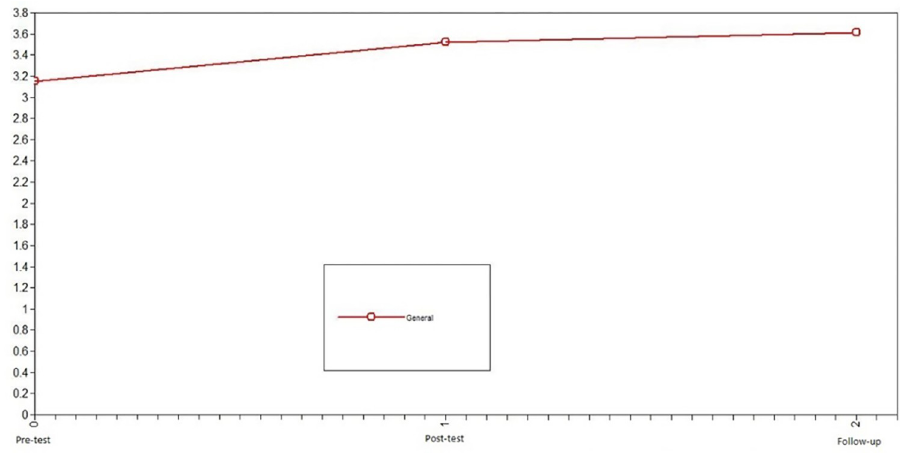
Fig 6. Latent growth curve models of prosocial behavior toward strangers of the intervention group. The model that presented the best fit was the nonlinear change model.